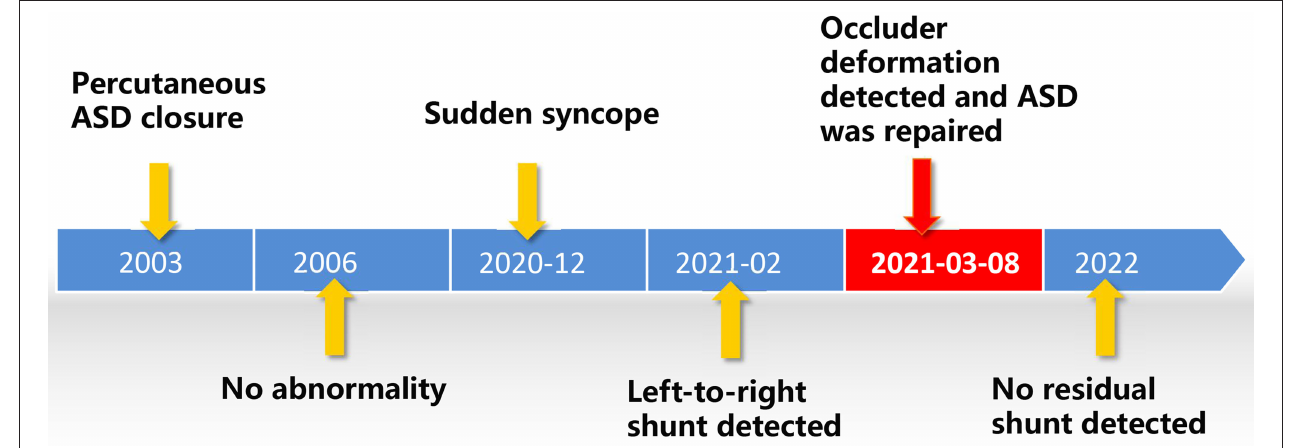
FIGURE 5 | A figure showcasing a timeline with relevant data from the presented case.